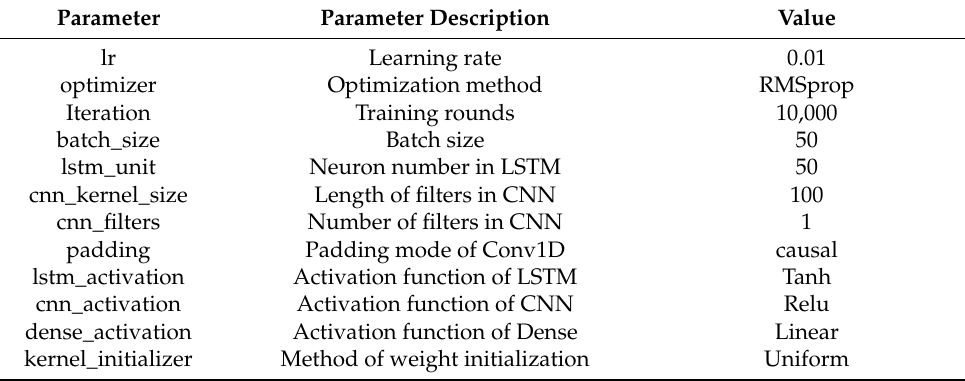
Table 3. Parameter setting. LSTM: long short-term memory; CNN: convolutional neural network.